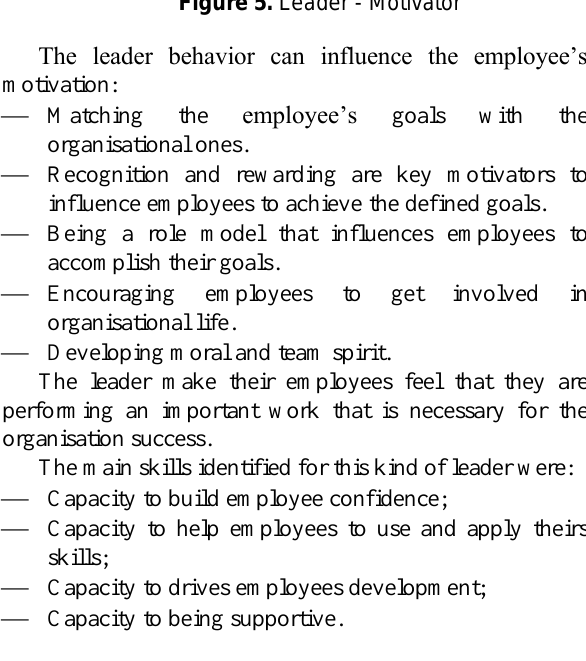
Figure 5. Leader -